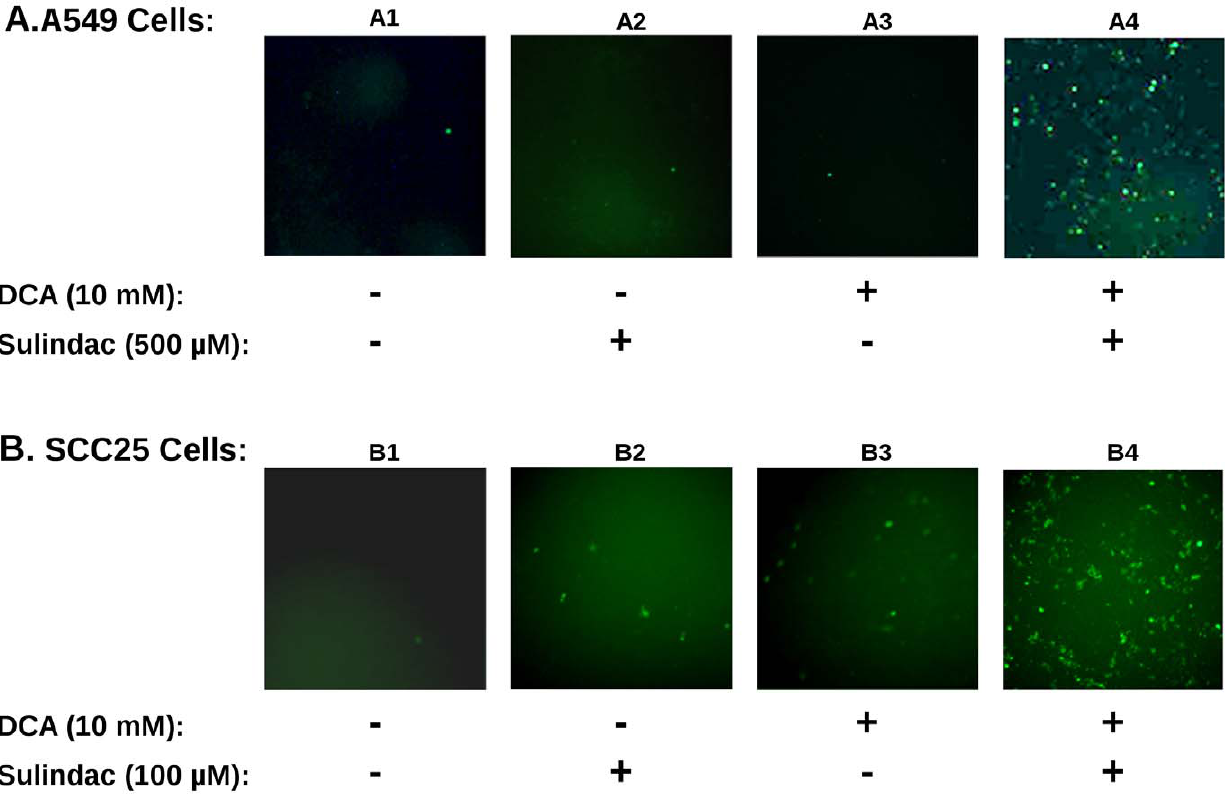
Figure 3. The combination of sulindac and DCA increases intracellular ROS levels in A549 and SCC25 cancer cells. Top panels (A) illustrate the results for A549 cancer cells while the bottom panels (B) depict the results for SCC25 cancer cells. The cells were treated with the indicated concentrations of drugs and processed for fluorescent microscopy as described in the Methods. The extent of intracellular ROS levels are illustrated as intensity of green fluorescence observed in cells treated with no drugs (sub-panels A1 and B1), sulindac alone (sub-panels A2 and B2), DCA alone (sub-panels A3 and B3), and sulindac and DCA combination treatment (sub-panels A4 and B4). Several independent fields were photomicrographed and representative fields for each condition are